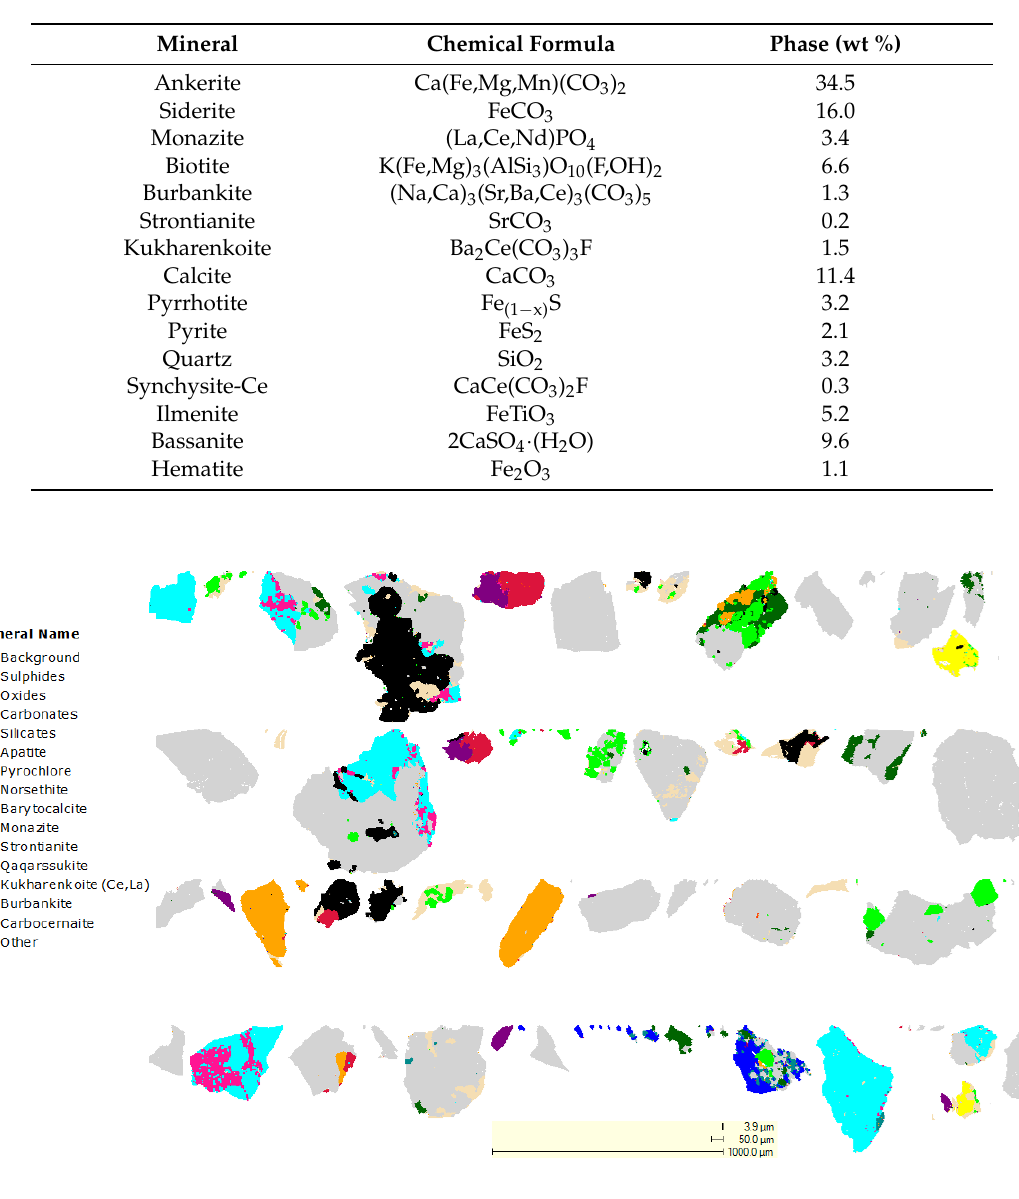
Figure 4. QEMSCAN schematics of mineralogical associations in the REE concentrate.